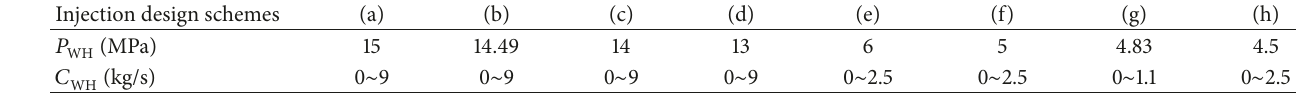
Table 2: The simulation injection design schemes.